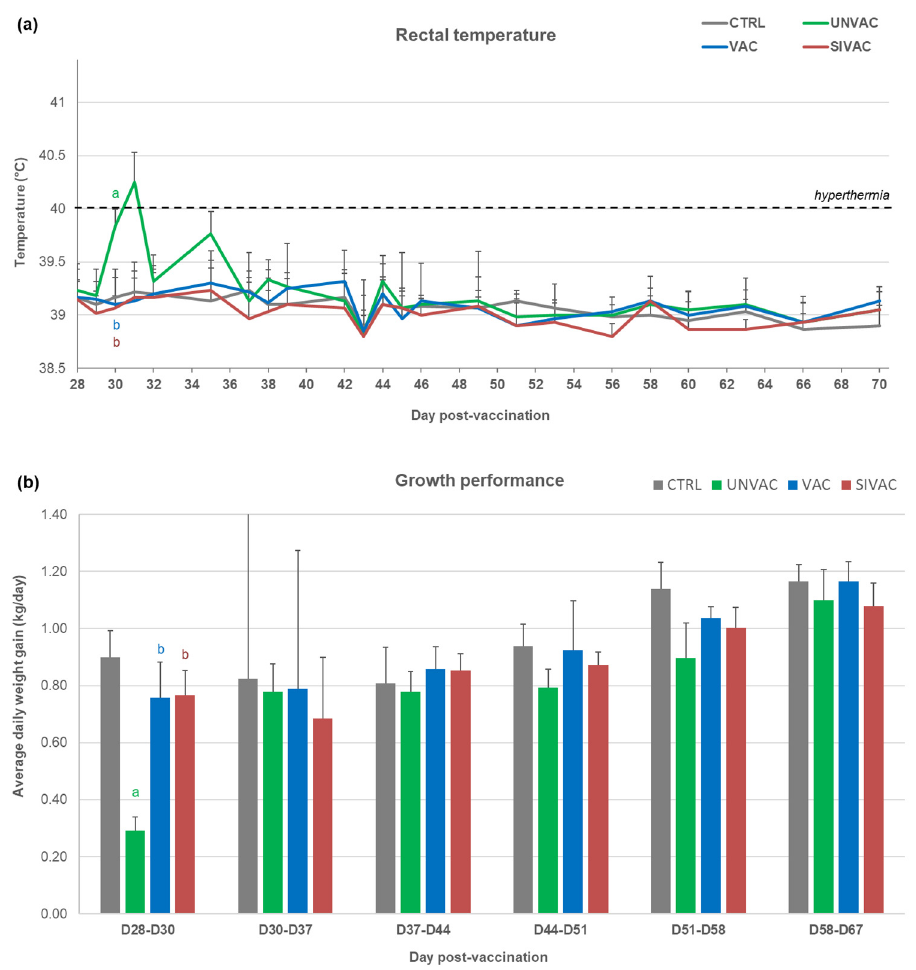
Figure 9. Clinical data recorded during the post-challenge period (D28 to D70 pv). ( a ) Rectal temperature; ( b ) Average daily weight gain of piglets. All data are reported as the mean ( ± SD) of the results obtained from piglets in each group. Different letters (a–c) indicate that the considered group (specified by its color) was significantly different from the CTRL group (a), from the UNVAC group (b) or from the VAC group (c) with p < 0.05. There is no significance c found in these graphs.